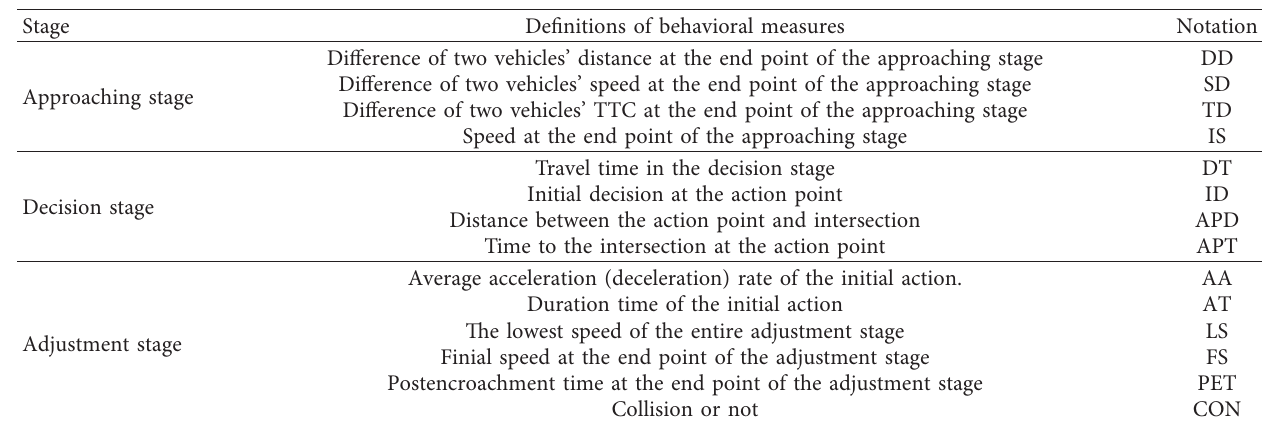
Table 1: Interpretation of